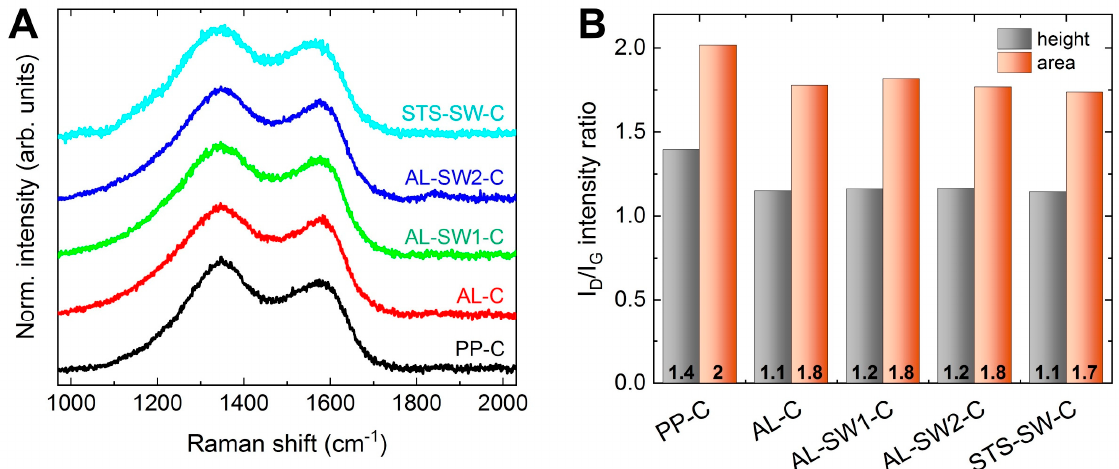
Figure 6. ( A ) D and G band regions in the Raman spectra of the carbonized nanofibers (lines are vertically shifted for clarity) and ( B ) the respective I D / I G ratios determined by deconvolution (see Figure S2 in the Supporting Information) given both as a ratio of peak height and as a ratio of peak area. The Raman spectrum of as-spun PAN nanofibers is shown for comparison in Figure S3 in the Supporting Information.